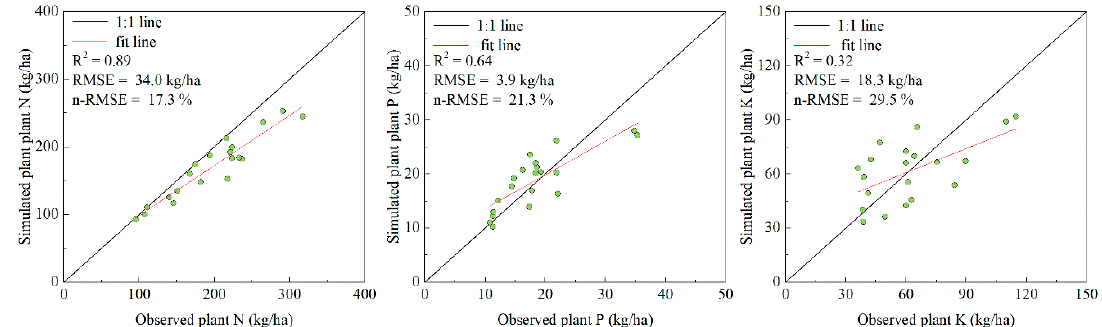
Figure 5. Comparisons of the simulated and observed data of the N, P, and K uptake in the total peanut dry plant matter in 2018. The observed data were obtained from the experimental field plots where a Nutrient Expert (NE) Decision Support System was applied; and the simulated nutrient uptake data were estimated using the QUEFTS model.